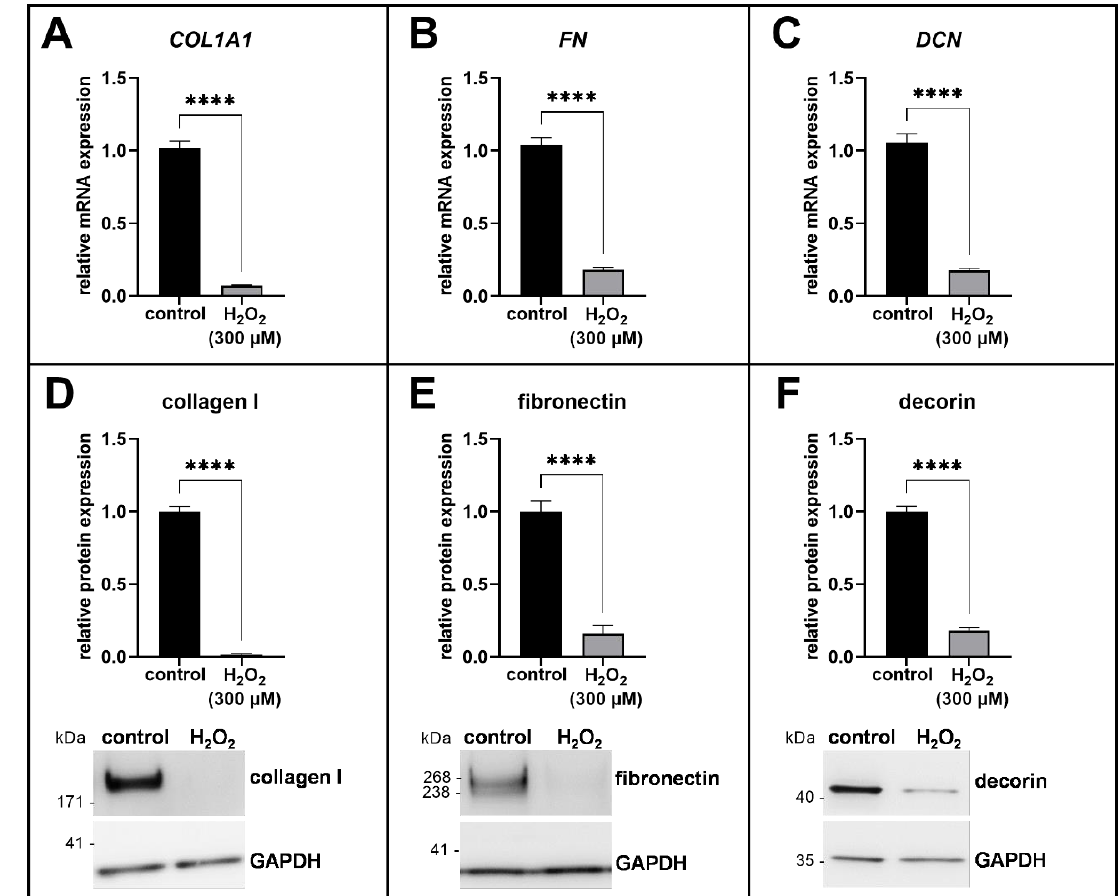
Figure 3. Analysis of ECM remodeling in acute senescent proto-myofibroblasts. After 24 h of cultivation, cells were treated for 1 h with 300 µM H 2 O 2 or H 2 O (control). Relative COL1A1 ( A ), FN ( B ) and DCN ( C ) mRNA expression levels were analyzed after 72 h of cultivation by quantitative real-time PCR and were normalized on GAPDH mRNA expression level. The protein expression levels of collagen I ( D ), fibronectin ( E ) and decorin ( F ) were detected after a cultivation time of 72 + 72 h via immunoblotting and normalized on GAPDH protein expression. Quantification was determined by using ImageJ. Values shown are means ± SEM for three biological and three ( A – C ) or one ( D – F ) technical replicate per experiment (n = 3) and calculated relative to the respective control. Mann- Whitney U test: p < 0.0001 (****).